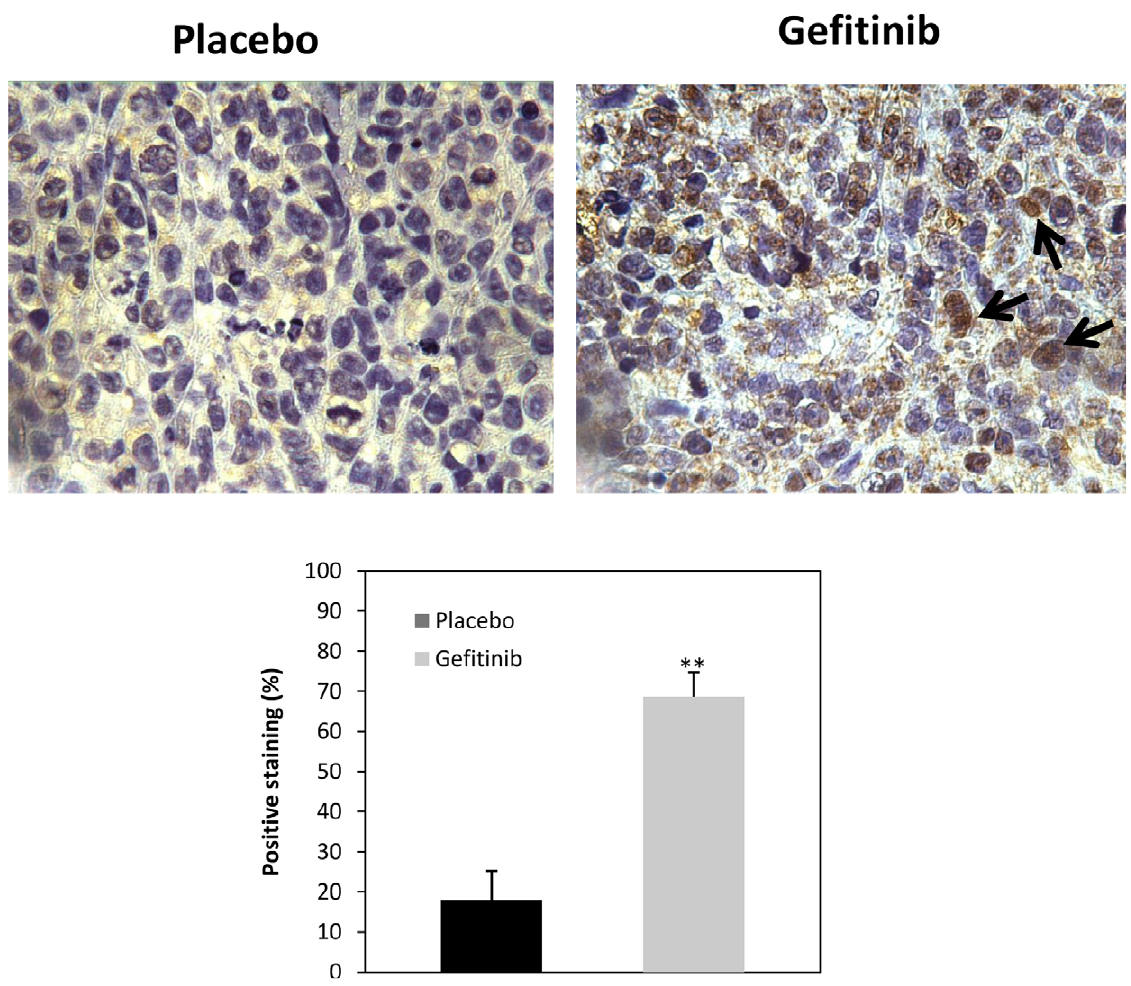
Figure 7. Immunohistochemistry (IHC) staining for PPAR c in tumor xenograft tissues Mice were treated with placebo or gefitinib (Gefitinib 2 mg/day, 5 times per week). Graphic on the lower level represents quantification of positive staining cells. Black arrows indicate nuclear staining.